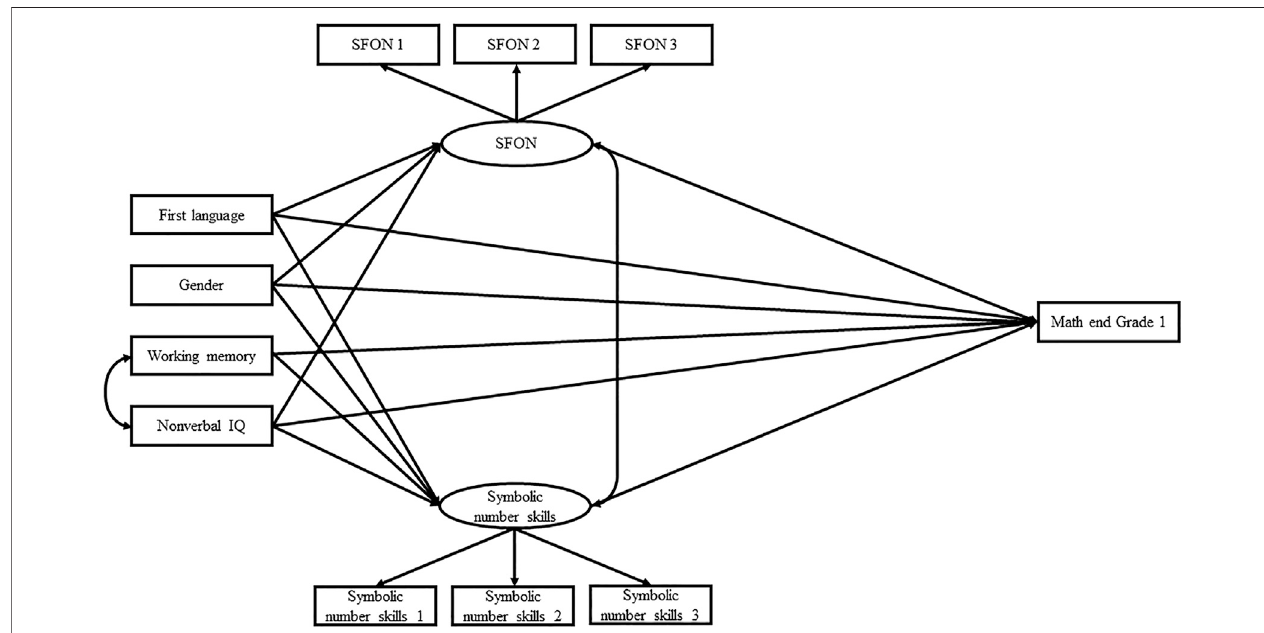
FIGURE2| Hypothesized Model.SFONandsymbolicnumberskillswillpredictmathematicalachievementattheendofGrade1whendataarecontrolledfornon- speci fi c predictors ( fi rst language, gender, working memory, nonverbal IQ). The oval symbols are latent variables that represent the variance shared by multiple indicators. The square symbols represent manifest variables.